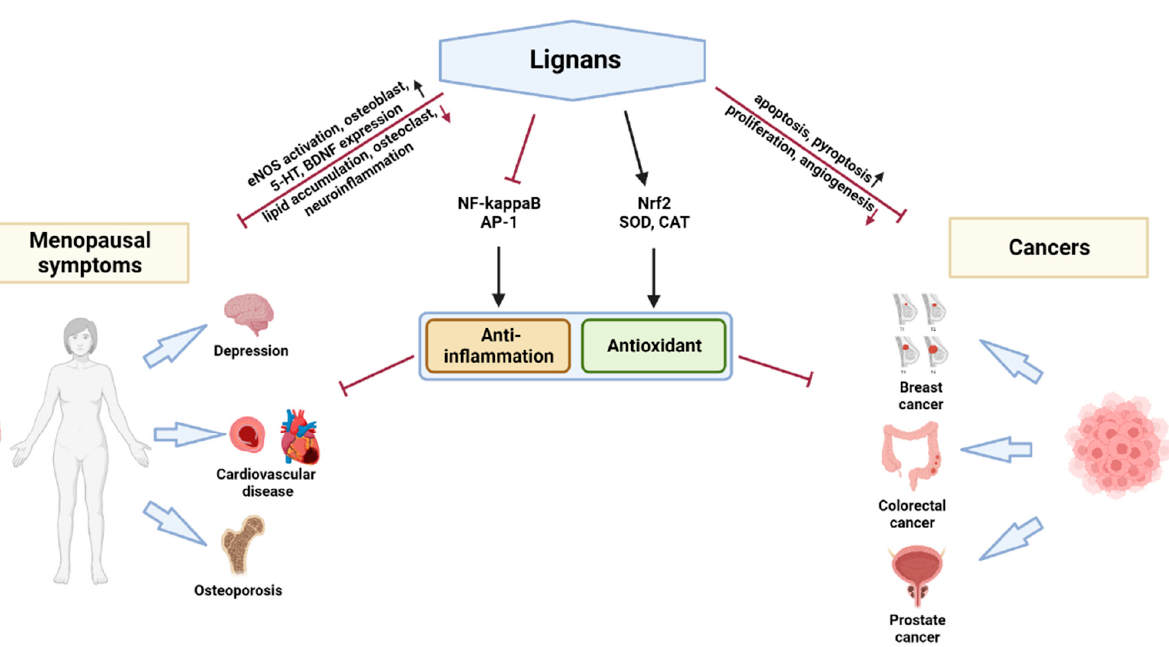
Figure 2. Schematic analysis of the therapeutic properties of lignans.